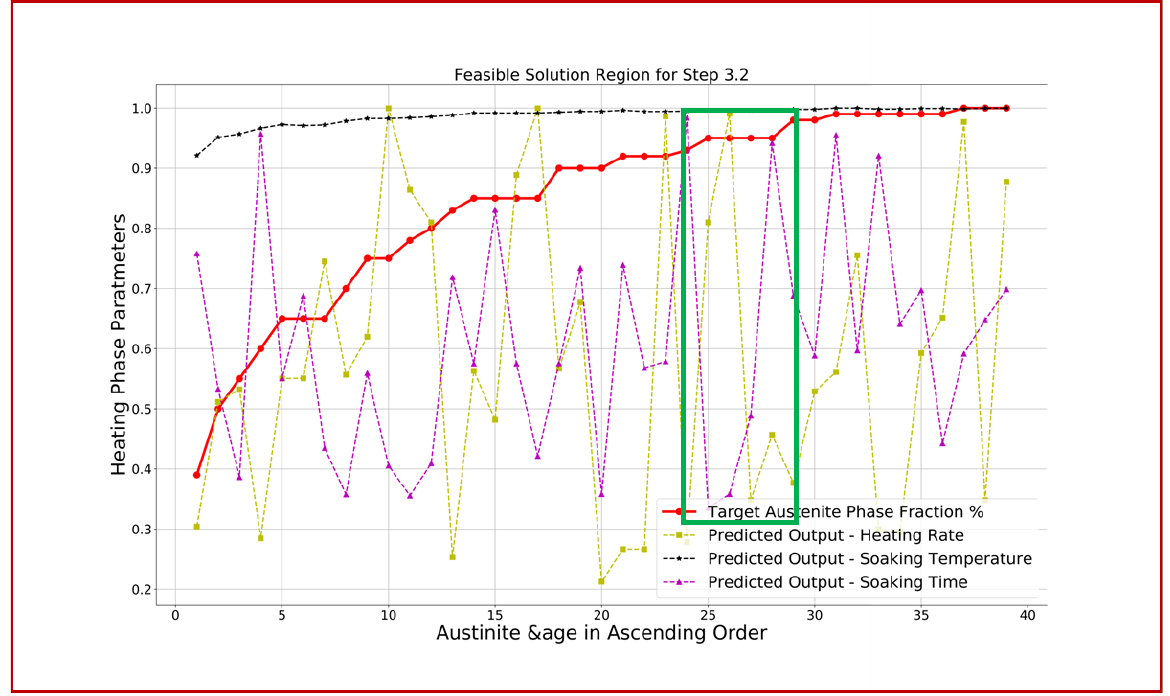
Figure 15. Feasible Region for Processing Parameters (Heating Phase). Table 14. Processing Parameters (Heating) Combinations Identified After Solution Space Exploration. Combinations of the Processing Parameters (Heating Phase) Identified after